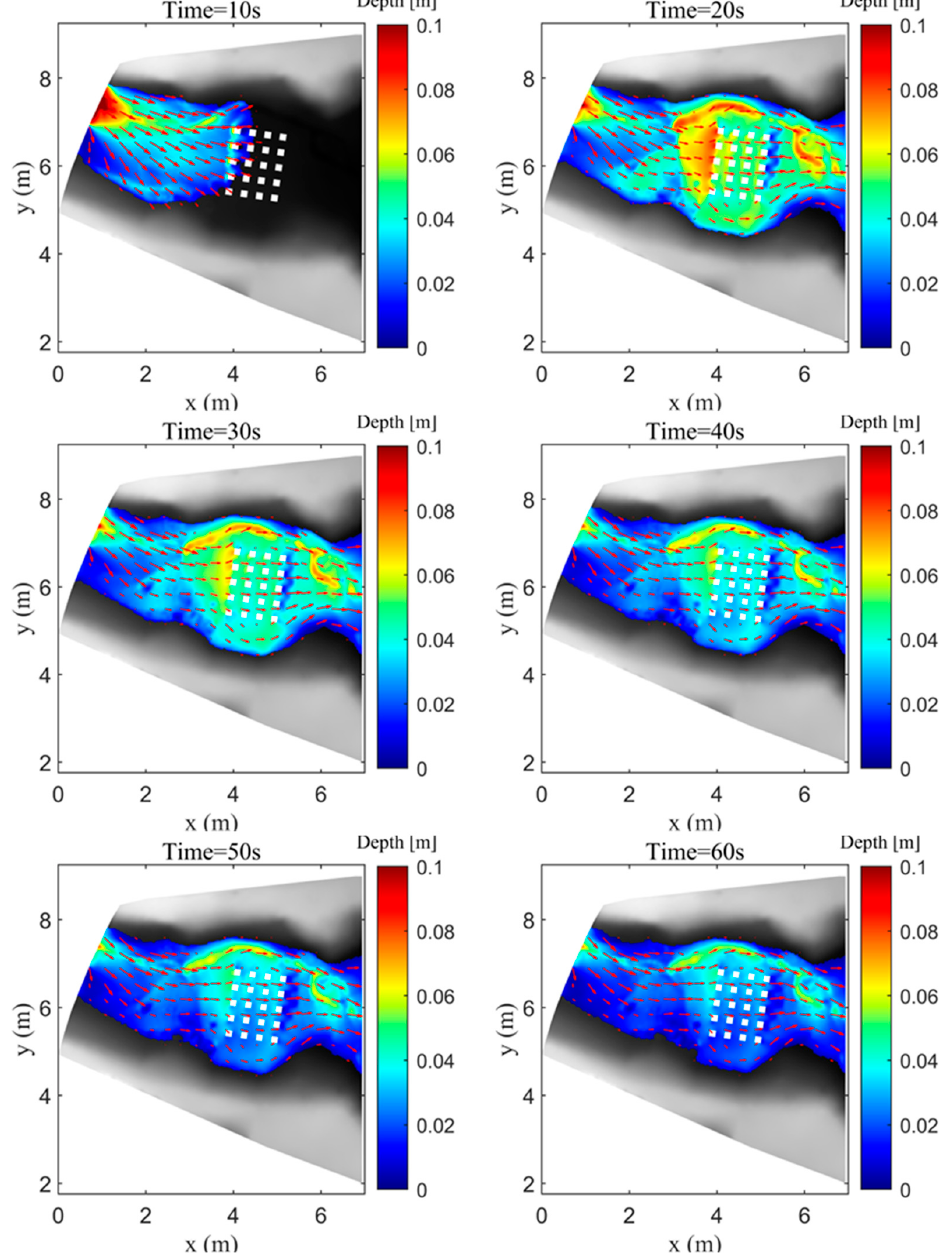
Figure 13. Flash fl ood in an urban area: simulated water depths and velocities. The calculated water depths at nine gauges are shown in Figure 14. The simulated results have good consistency with the measured results. Meanwhile, the simulation results can almost accurately predict the arrival time of the peak and maximum water depths. Comparison of the calculated and measured water depths at P5 showed a slight di ff erence. This result might due to the SWEs being unable to account for the three-di- mensional transient and turbulent water fl ow. All in all, this case study reveals that the present overland model can simulate the in fl ow-induced overland fl ow of water in an urban area well, accounting for the blocking e ff ect of urban buildings.